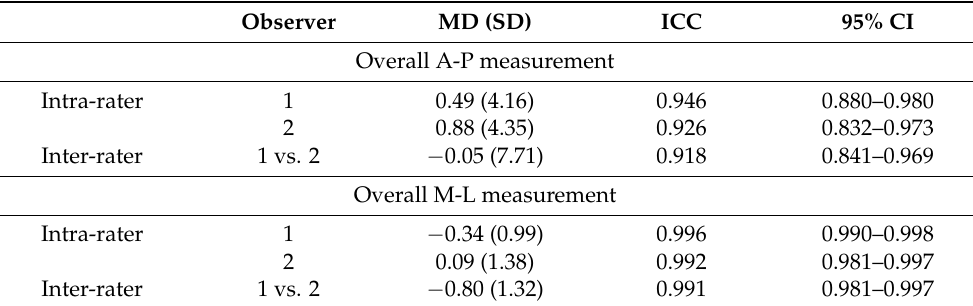
Table 3. Intra-rater and inter-rater reliability of shape measurements.